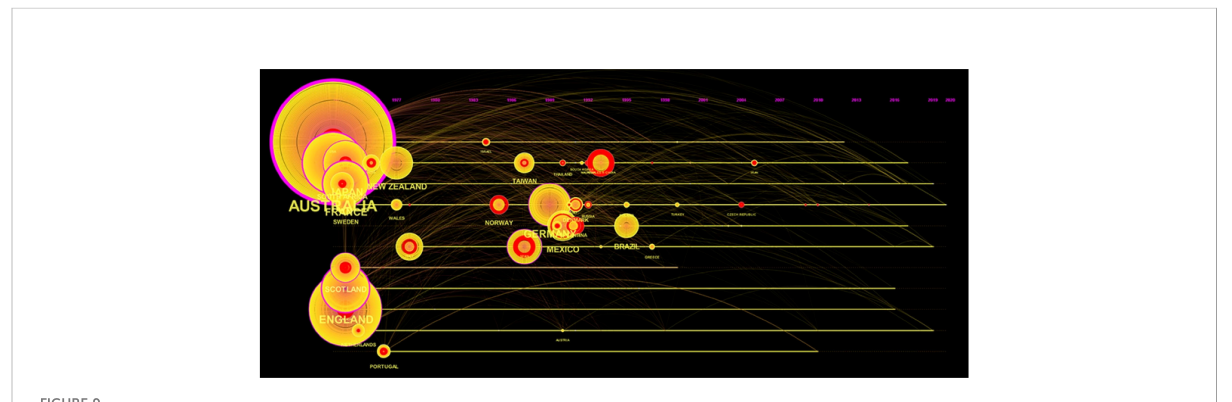
FIGURE 9 Country burstiness in marine lobster research between 1970 and